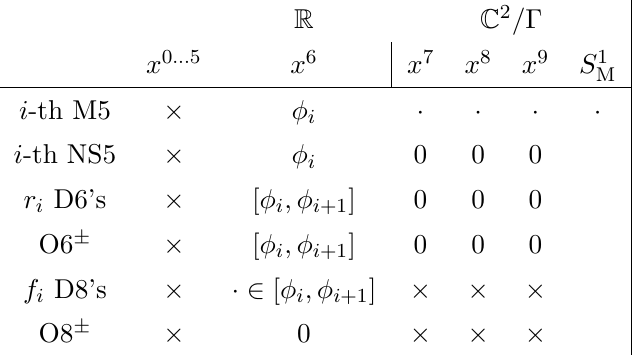
Table 1. NS5-D6(-O6)-D8(-O8) brane scan. A means the brane is sitting at a point along that di- (cid:1) rection; means it is in(cid:12)nitely extended along that noncompact direction. When (cid:0) = D k O6-planes (cid:2) are present, and are overlaid onto the D6-branes. The O8-plane can either sit at 0, between the